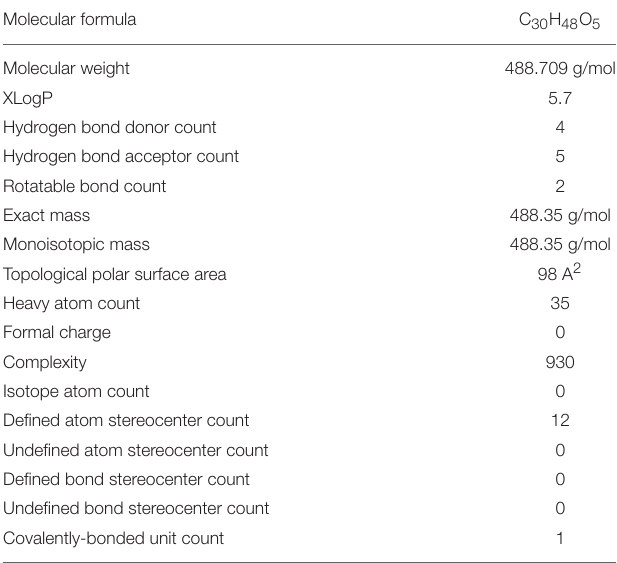
TABLE 3 | The physicochemical properties of asiatic